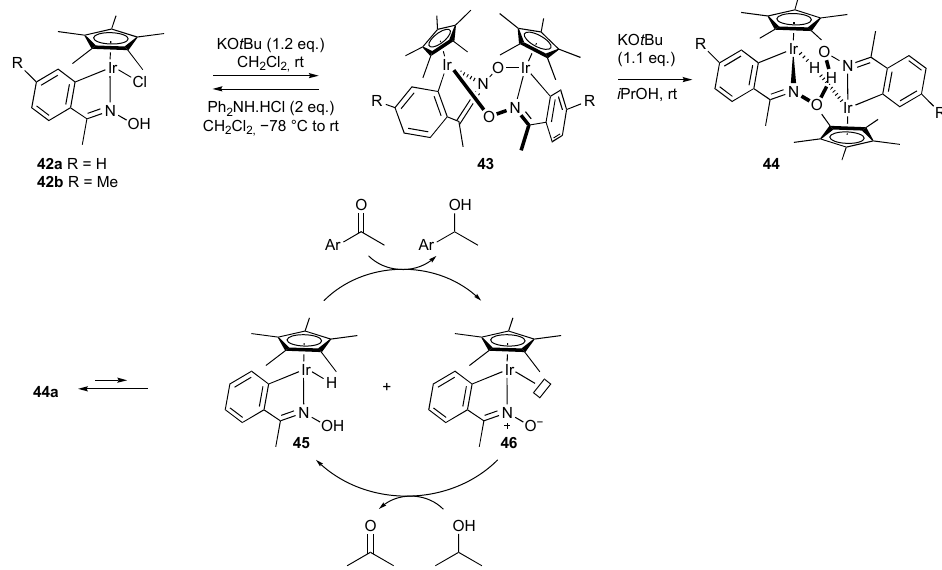
Molecules 2021 , 26 , x FOR PEER